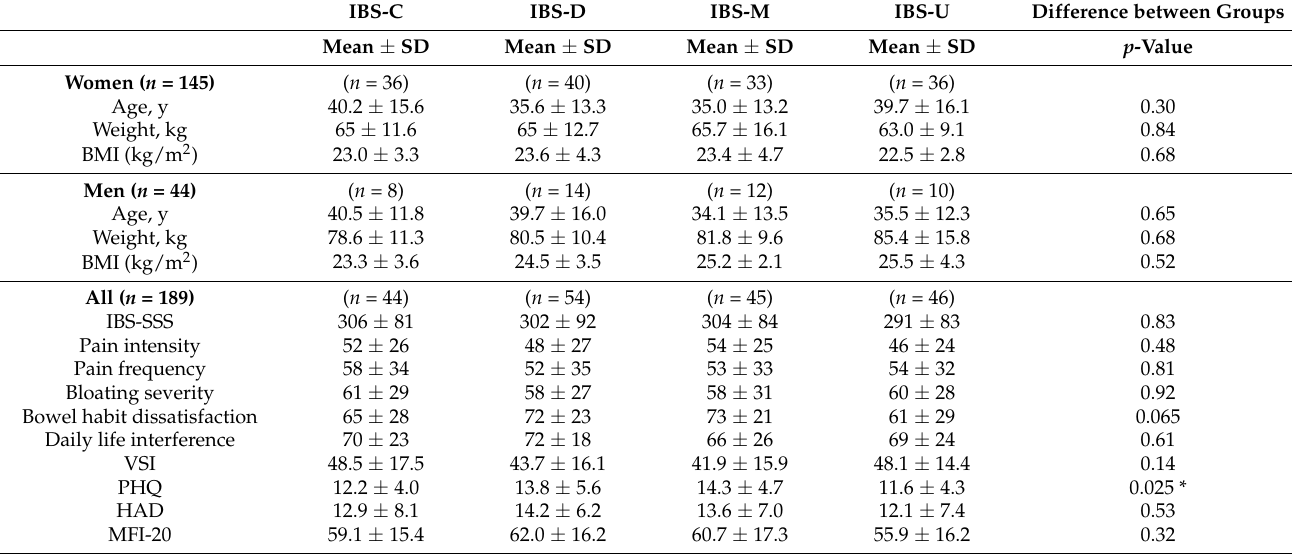
Table 1. Demographic and clinical data among all women and men with irritable bowel syndrome participating in the